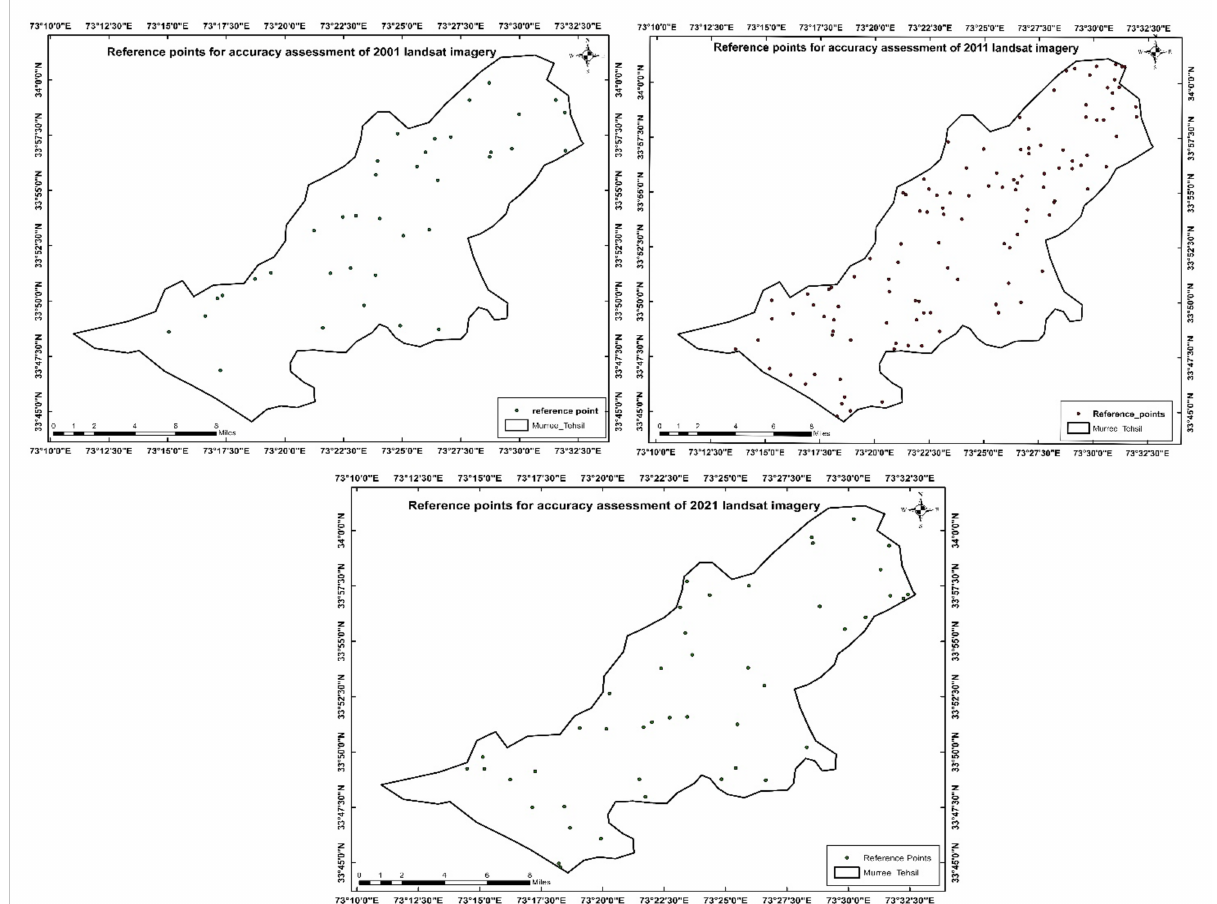
Figure 3. Map showing reference points for accuracy assessment of 2001, 2011 and 2021 Landsat imagery.